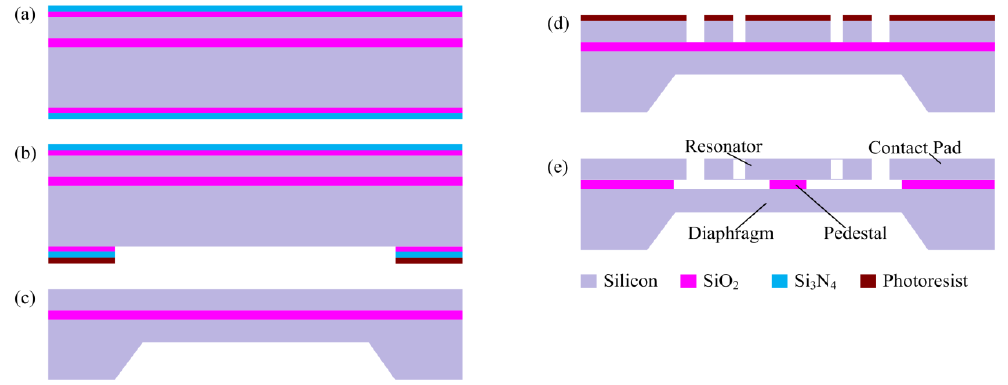
Figure 7. Fabrication process of the resonant pressure sensor.